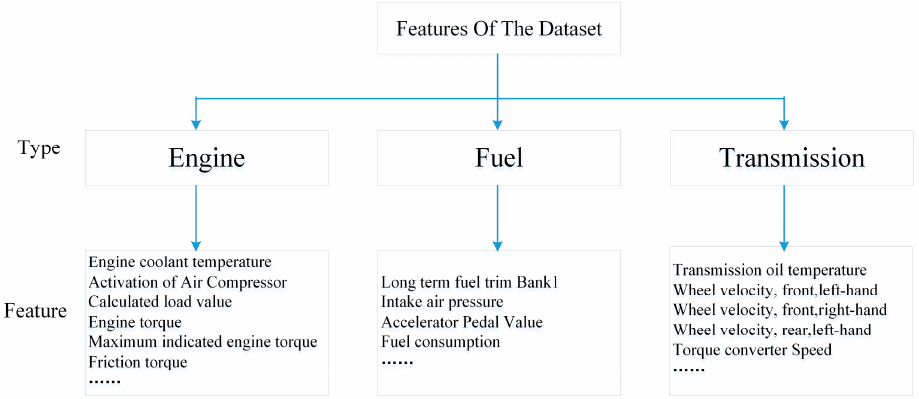
Figure 2. The data structure of Ocslab driving dataset.